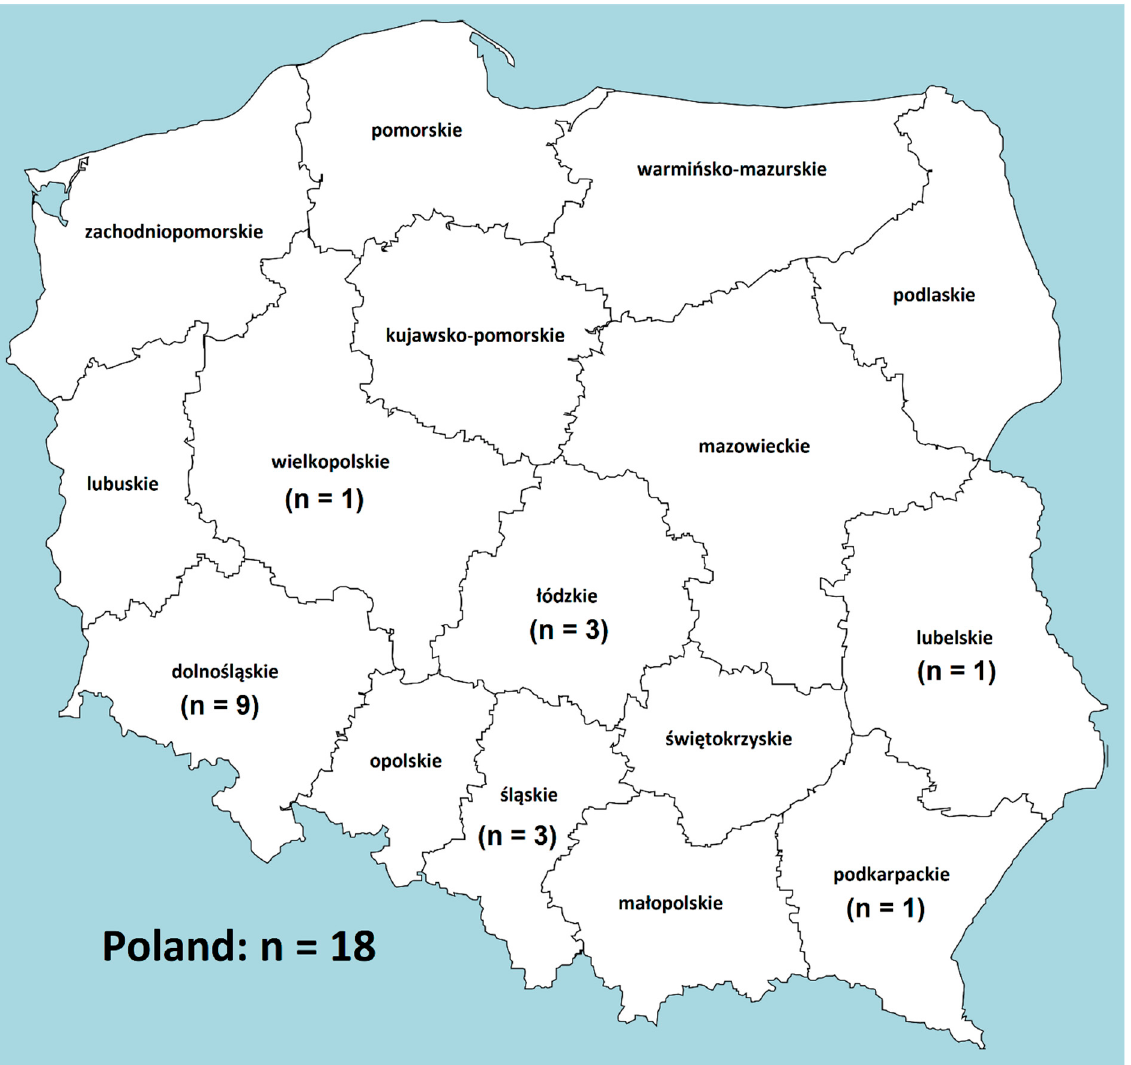
Figure 4. The geographical distribution of the analysed S. Kentucky strains isolated in 2018–2019 from patients in Poland.